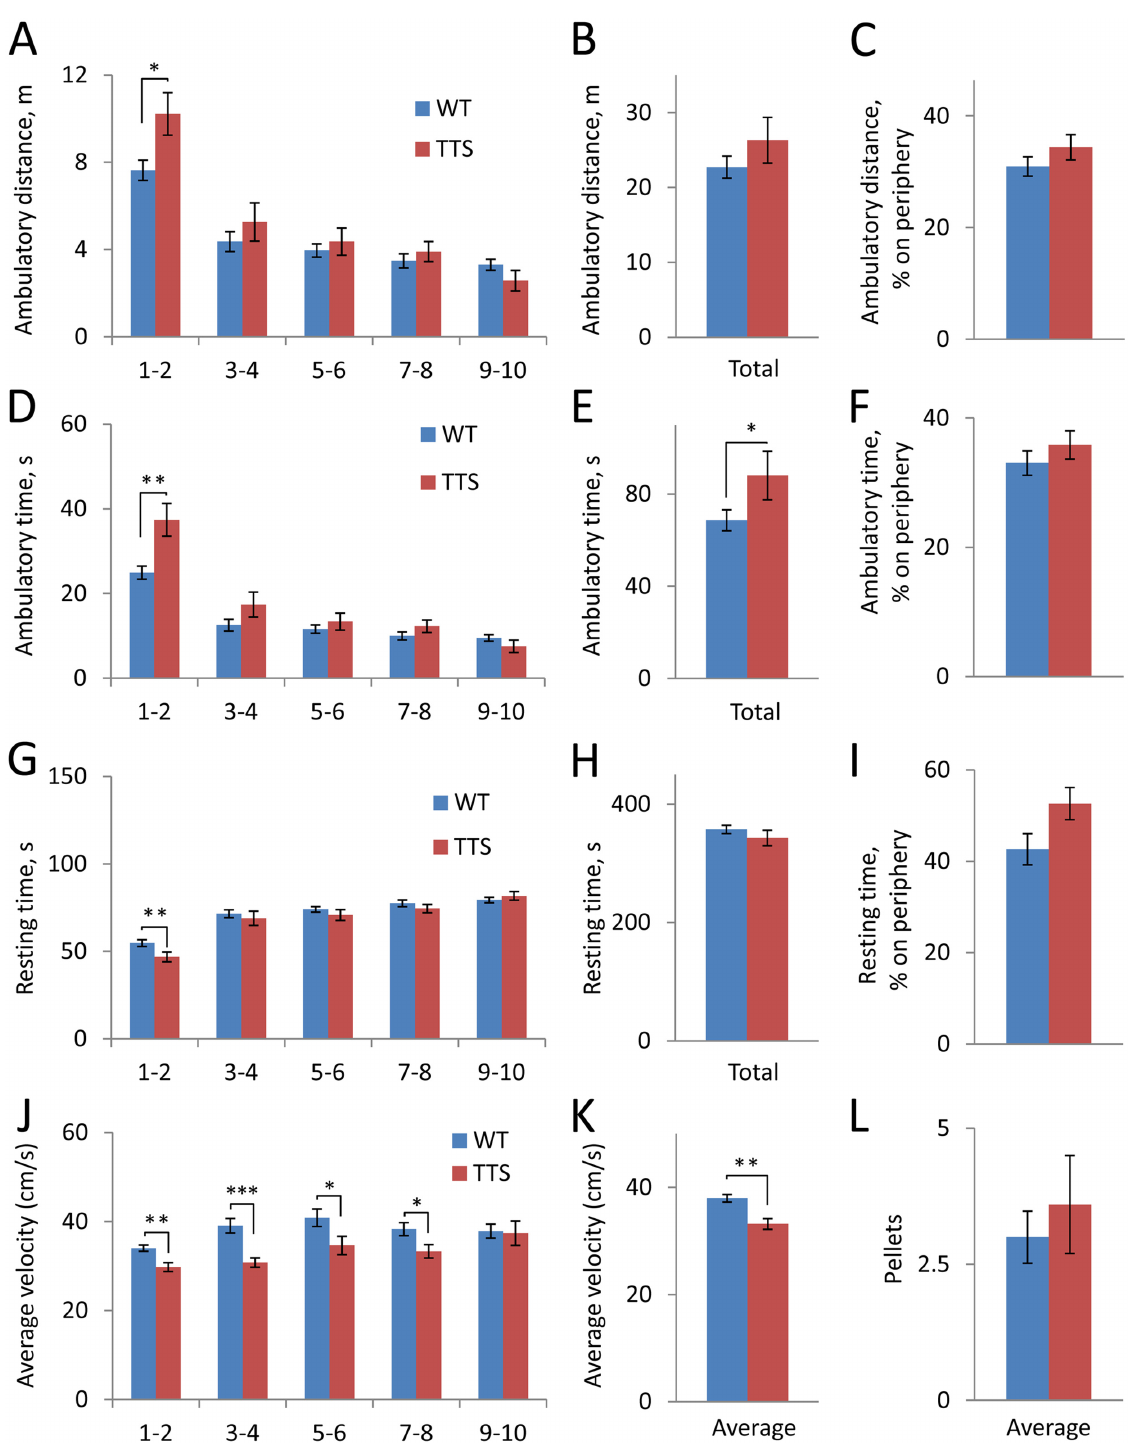
Fig 2. Spontaneous locomotor activity. A-C: Ambulatory distance; D-F: Ambulatory time; G-I: Resting time; J-K: Average velocity. The values averaged for 2-min sequential periods (A, D, G, J) and for the total 10-min testing period (B, E, H, K) are shown. Also, the percentage of distance and time on the arena periphery (C, F, I) are shown. L: Number of pellets dropped during the test. All results are mean ± SEM. Number of mice examined: WT = 22; TTS = 12. * p < 0.05, ** p < 0.01, and *** p < 0.001, significantly different from WT mice.